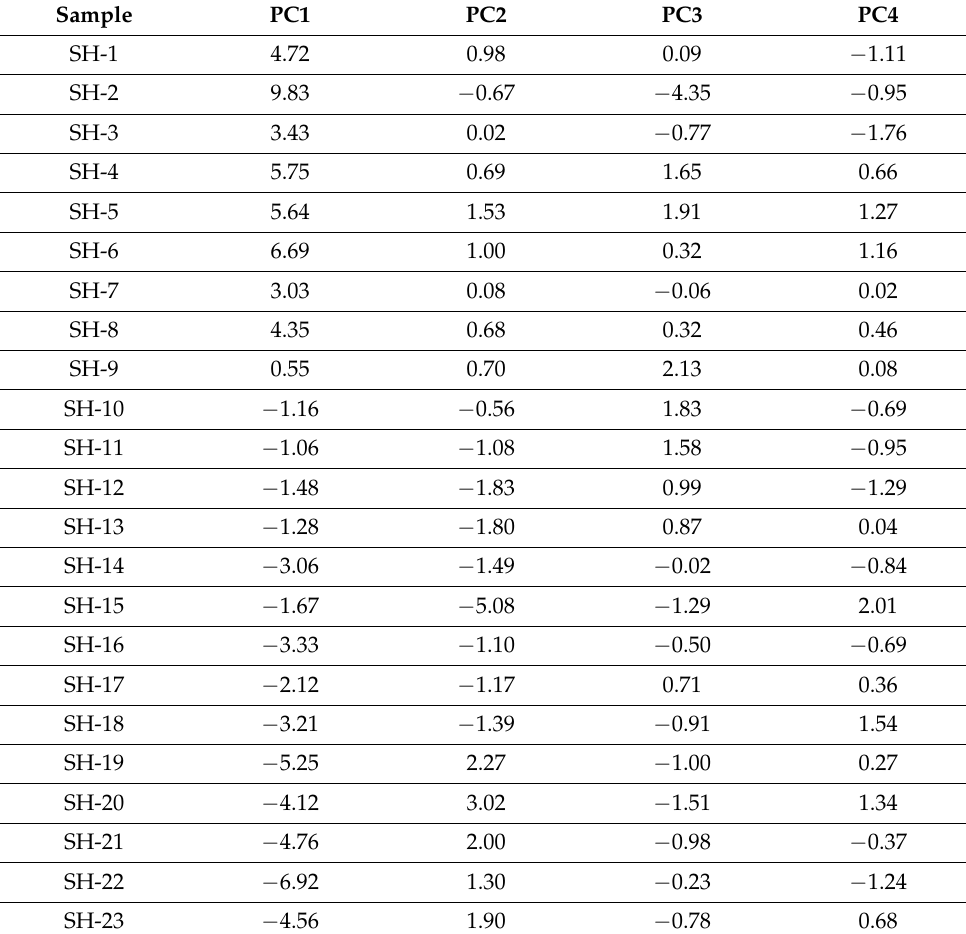
Table 4. Results of principal component (Q-mode) analysis, four components (PC1-PC4) are extracted with the PC1 and PC2 are the most important. Significant values are in bold. Sample PC1 PC2